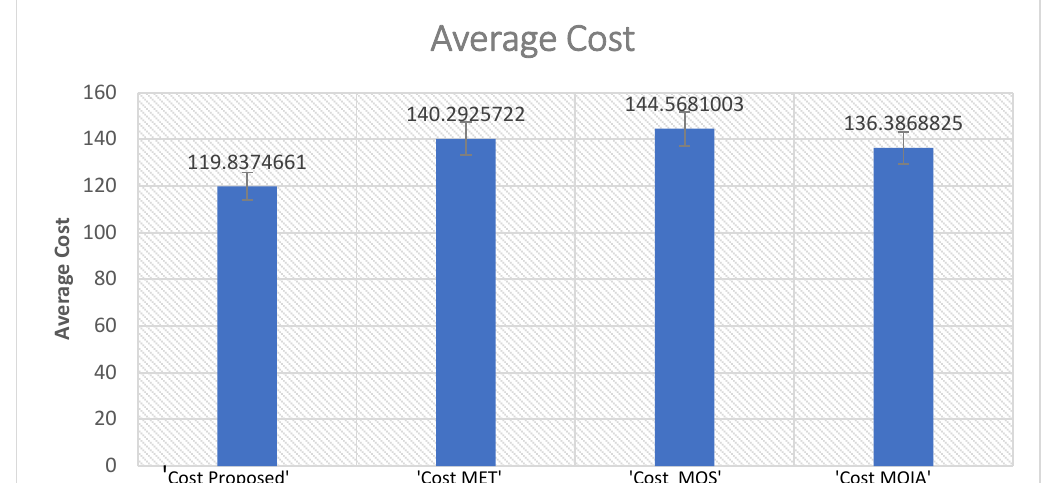
Figure 6. Average Cost.